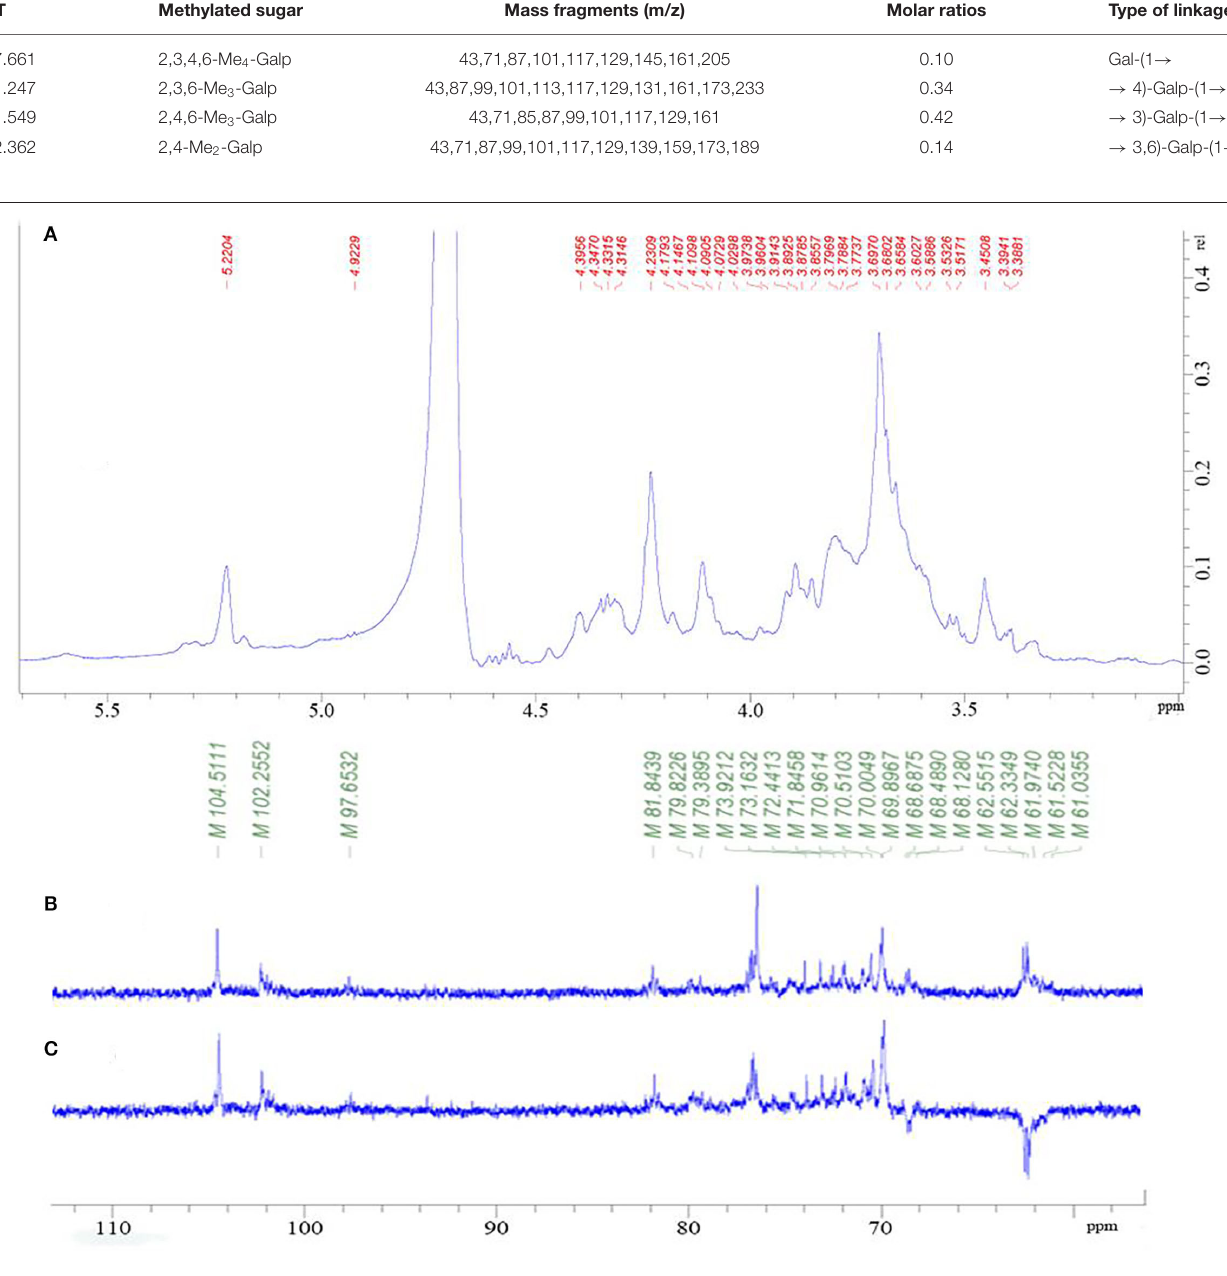
FIGURE 2 | 1 H NMR spectrum of PGP (A) ; 13 C-NMR spectrum of PGP (B) ; DEPT135 spectrum (C) of PGP.